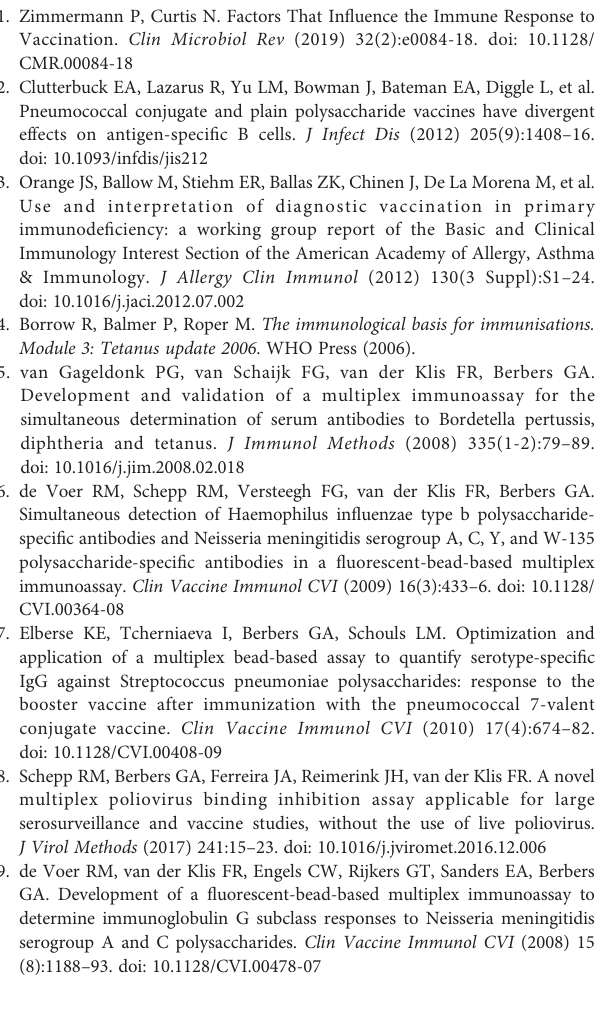
Supplementary Table 1 | Correlation (Spearman correlation coef fi cients with 95% con fi dence intervals and p-values) for pairwise comparisons of antibody